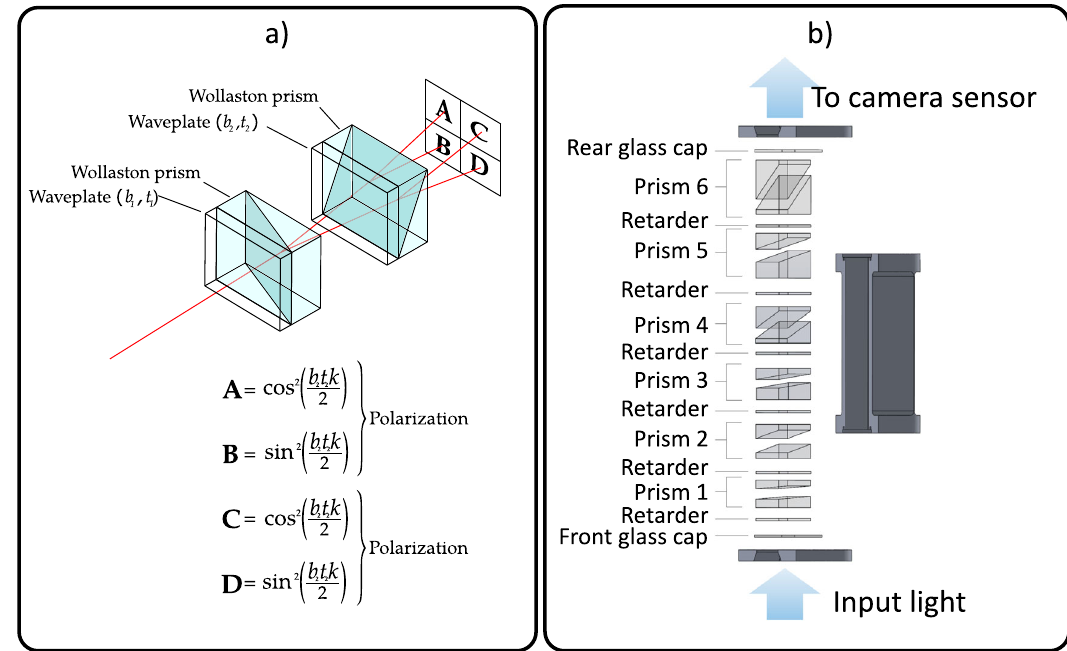
Fig. 5 Birefringent spectral demultiplexing and IRIS birefringent spectral demultiplexer design. a Diagram of a four-way birefringent spectral demultiplexer. Incoming signal is split into four different regions which can be imaged with a camera sensor. b Design used for IRIS which produces two sets of 32 channels with orthogonal